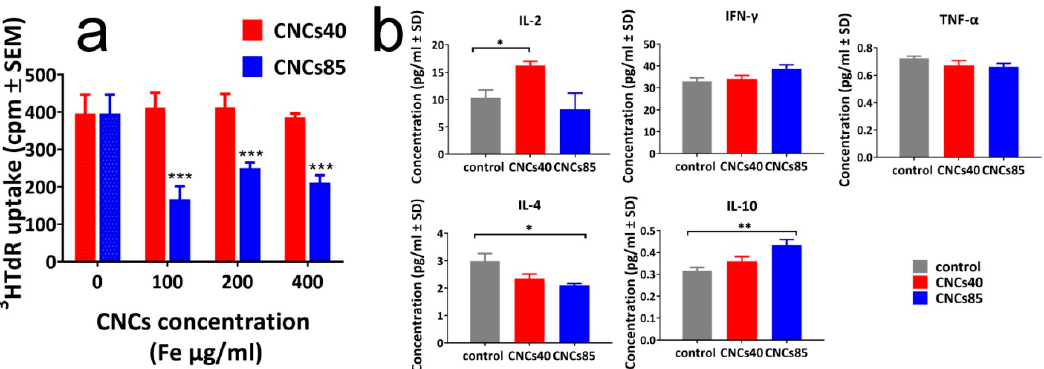
Figure 5. ( a ) Mouse spleen cell proliferation in the presence of CNCs of 40 nm and 85 nm in diameter was tested by 3 HTdR incorporation assays 48 h after culture initiation. The results represent the mean of three different experiments and are expressed as cpm ± SEM; ( b ) Detection of cytokines in the supernatants of spleen cell cultures in the presence or not of CNCs at the concentration of 200 μ g/mL. The results represent the mean of three experiments and are expressed as pg/mL ± SD. *: p < 0.01, **: p < 0.005 , ***: p < 0.001 (see experimental).